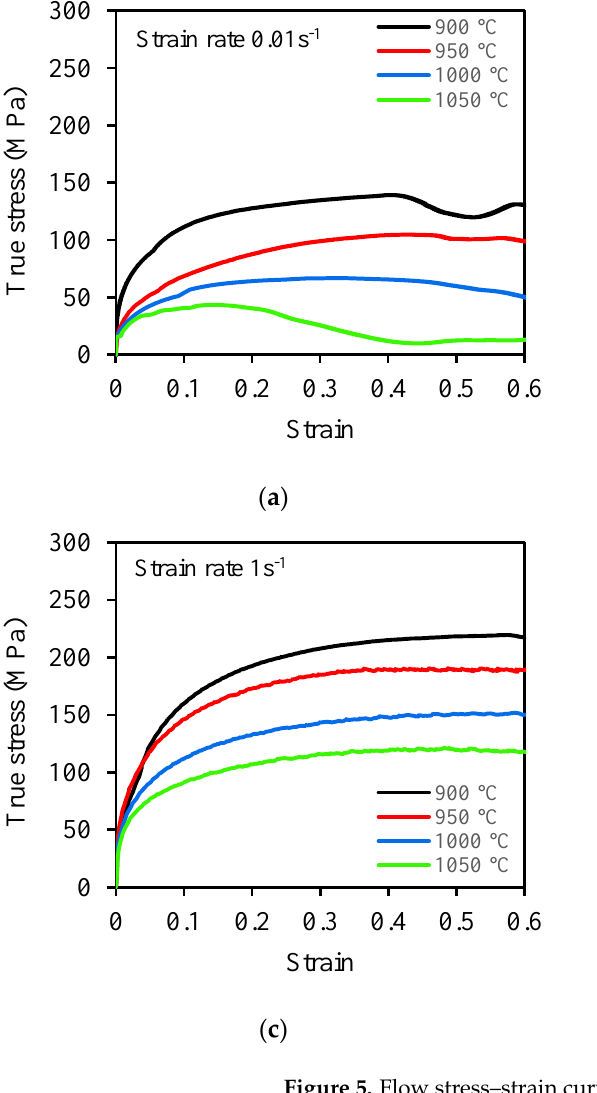
Figure 5. Flow stress–strain curve of steel A.